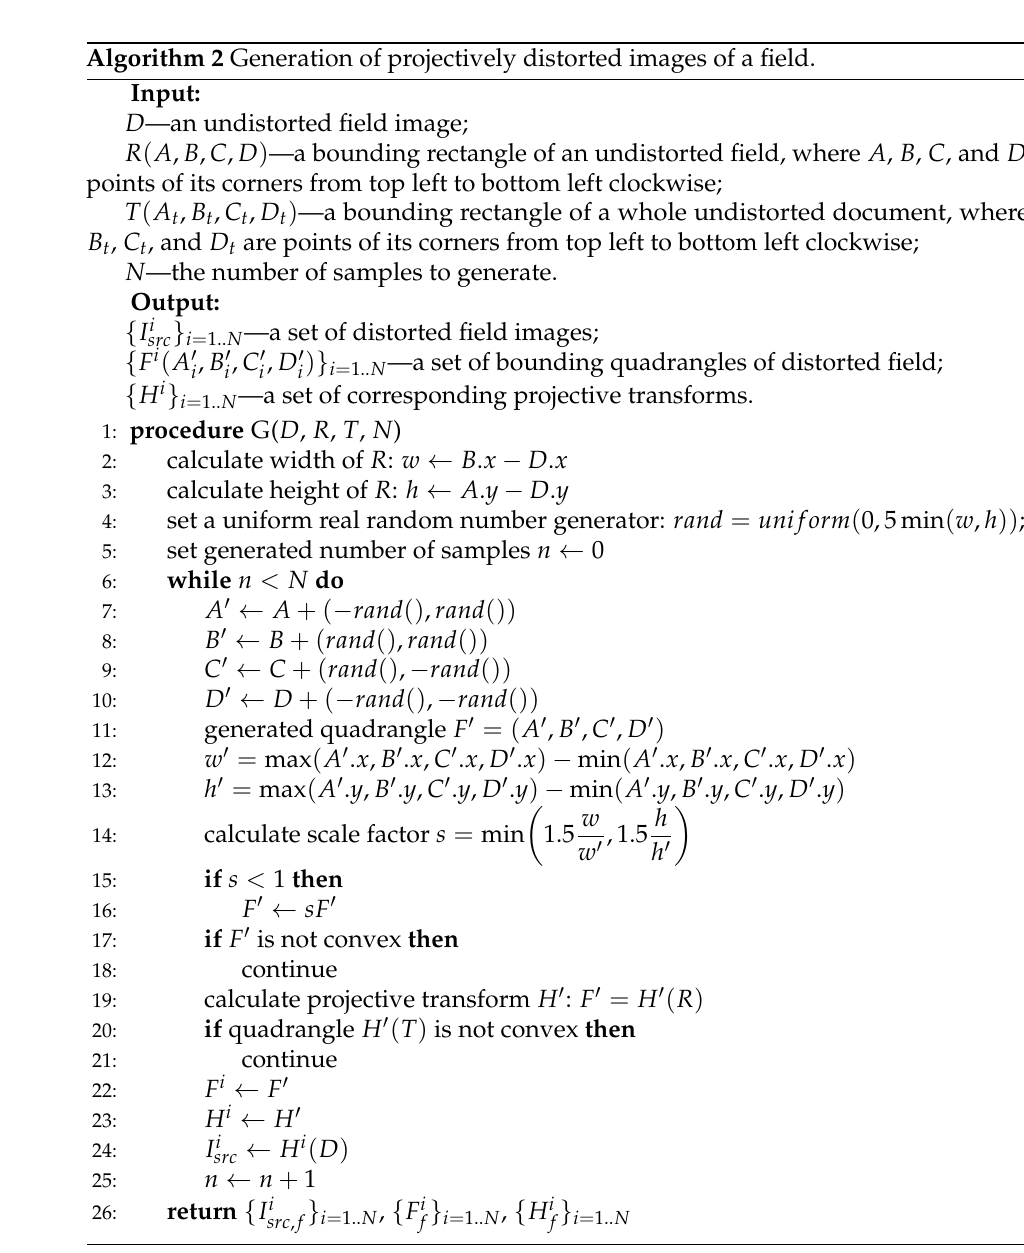
Algorithm 2 Generation of projectively distorted images of a